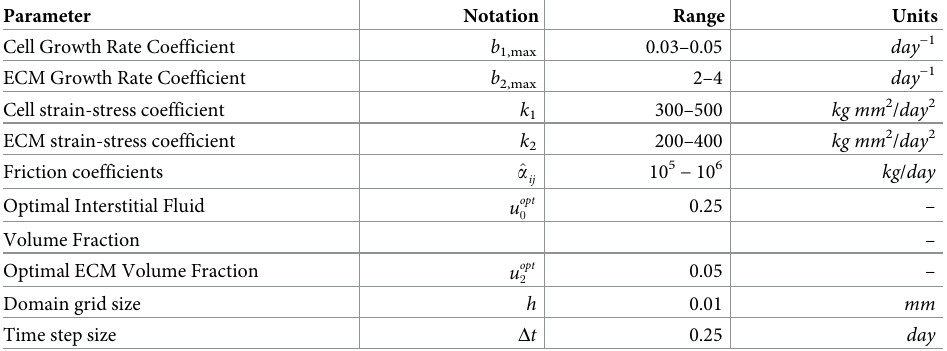
Table 1. Parameter values for the experiments in tissue regeneration.